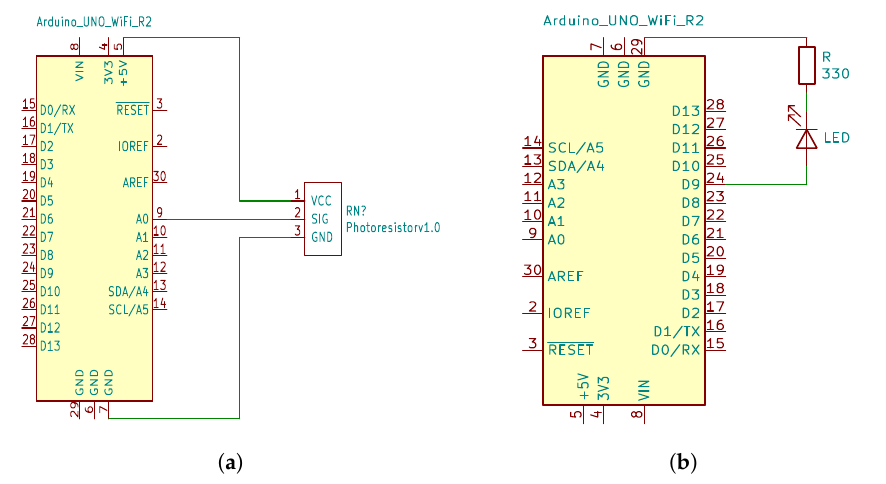
Figure 7. Circuit diagram of the Luminance sensing use-case, ( a ) Publisher, and ( b )